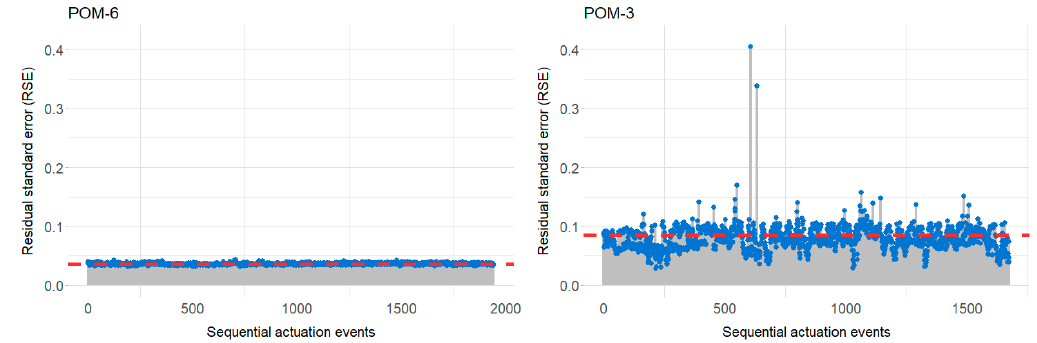
Figure 8. Sequential RSE values plots for point-operating machine POM-6 ( n = 1943) and POM-3 ( n = 1674). Possible baseline for each instrument shown in red.